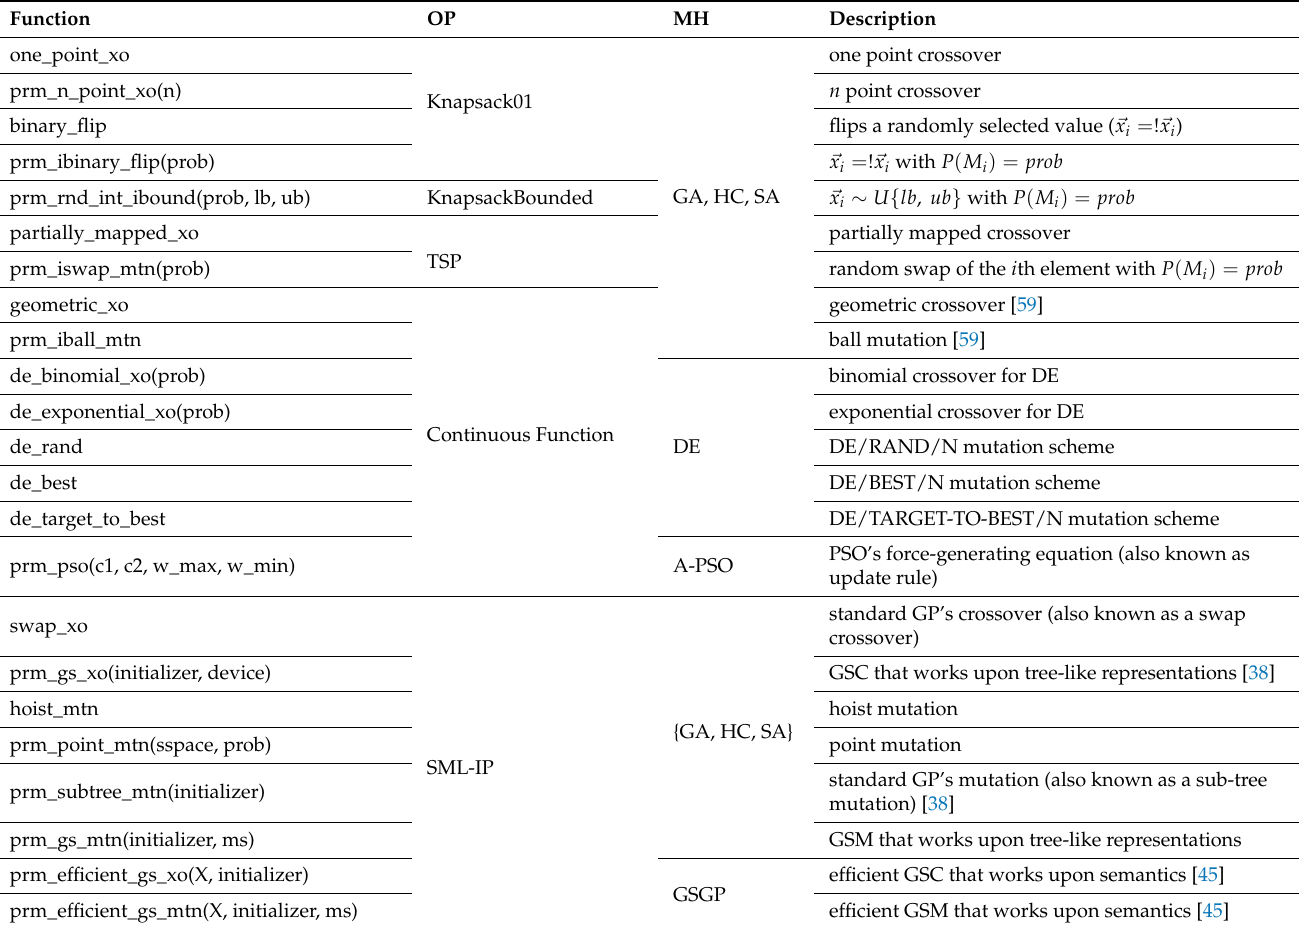
Table 3. Descriptions of the variators